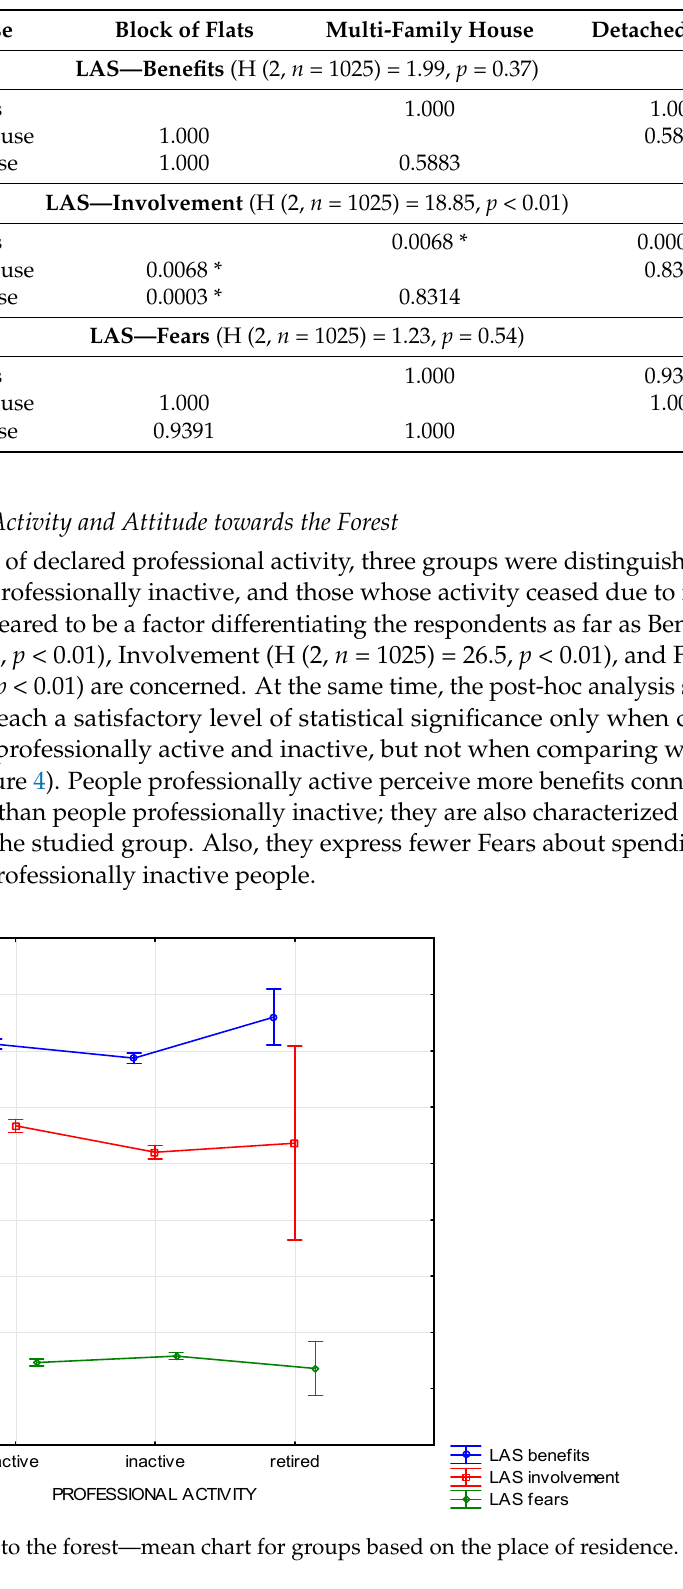
Figure 5. Attitude to the forest—mean chart for groups based on type of occupation.